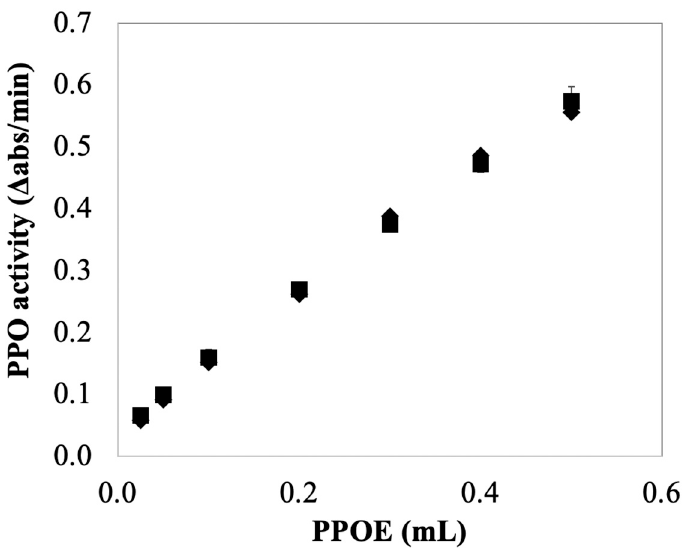
Figure 6. Effect of enzyme concentration, as an amount of PPO extract (PPOE) on PPO activity measurements using CA as a substrate. PPO reaction mixtures contained 1 mM CA and 50 mM sodium phosphate buffer, pH 7.0. Reactions were initiated by adding 0.2 mL PPOE with ( ■ ) and without ( ◆ ) AA (AA at 3 mM when present) to 2 mL reaction mixtures. Data points represent means ± standard deviations for triplicate assays. Data points without visible error bars have standard deviations smaller than the designated symbols.